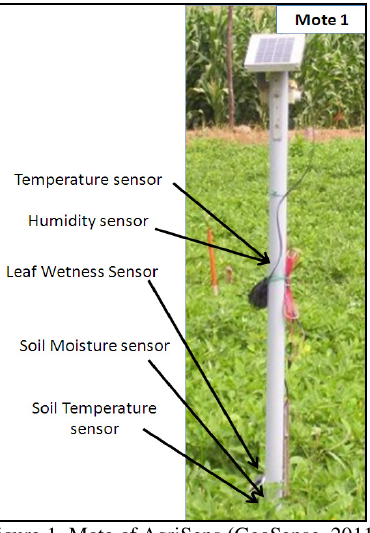
Figure 3. FieldServer installed in